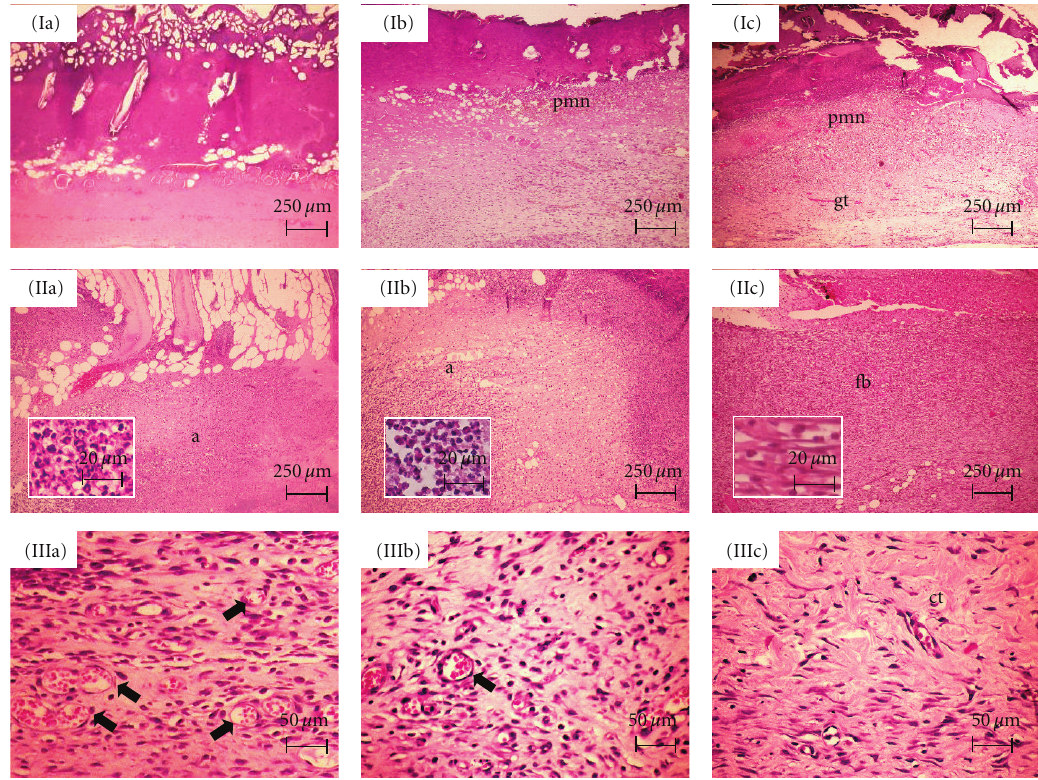
Figure 2: Histological sections stained in HE. Seven days: (Ia) Lack of inflammatory response in the center of the burned area in COL. (Ib) Inflammatory infiltrate rich in polymorphonuclear neutrophils (pmn) in PHO. (Ic) Expressive content of polymorphonuclear neutrophils (pmn) in the top of the wound, and early granulation tissue (gt) formation in the bottom, in UAL. Fourteen days: (IIa and IIb) Intense acute inflammatory reaction (a) scattered within the burned area in COL and PHO, respectively. Neutrophils seen in detail. (IIc) Moderate infiltrate of neutrophils and lymphocytes in association to expressive fibroblastic proliferation (fb) in UAL. Fibroblasts seen in detail. Twenty- one days: (IIIa and IIIb) Vascular component (arrows), and chronic inflammatory infiltrate, still evident in COL and PHO, respectively. (IIIc) Scanty inflammatory cells are seen within the cicatricial tissue (ct) in